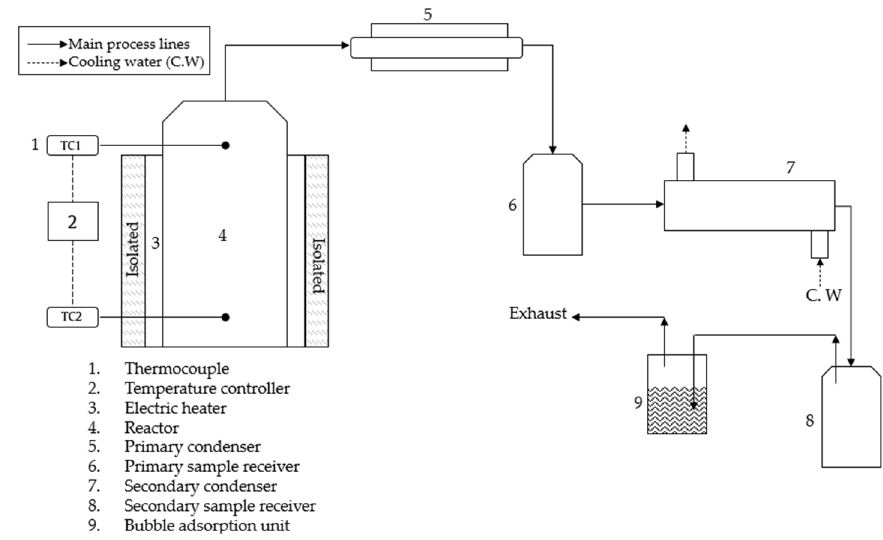
Figure 1. EPS pyrolysis experimental scheme.